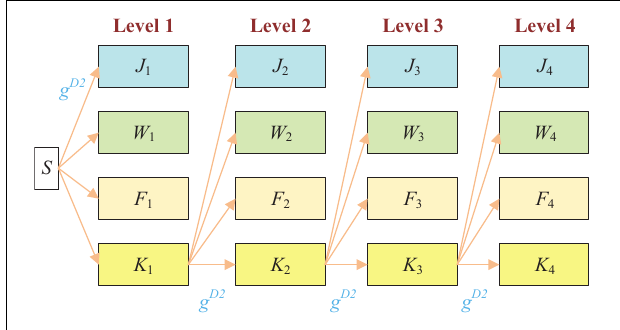
FIGURE 2 | A schematic of a four-level 2D-DWT.